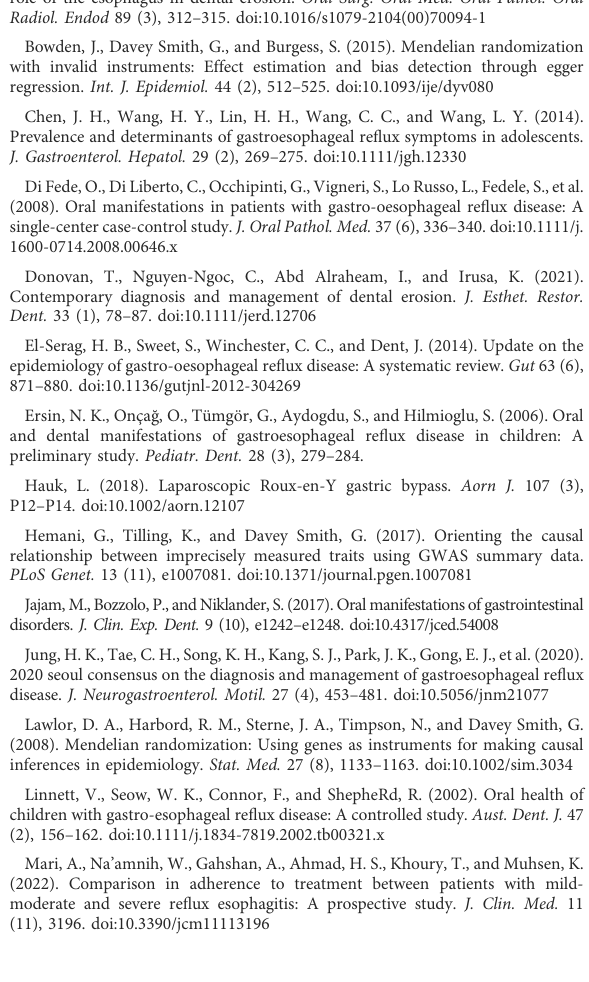
SUPPLEMENTARY TABLE S3 The instrumental variation SNPs selected for MR analysis after removal of outlier SNPs. SUPPLEMENTARY TABLE S4 The heterogeneity results of MR analysis from the Cochran ’ s Q test after removal of outlier SNPs. SUPPLEMENTARY TABLE S5 The pleiotropy analysis results of MR